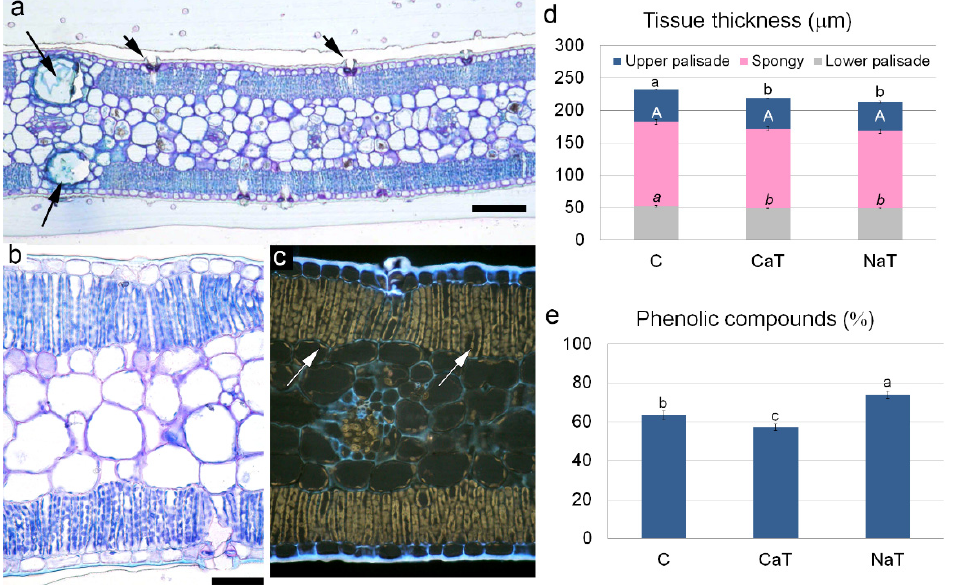
Figure 1. Light ( a , b ) and epi-fluorescence ( c ) microscopy views of leaf lamina cross sections of C . citrinus control leaves. In ( a ), long and short arrows point to glands and cuticular waxes on stomata guard cells, respectively. Effect of salinity on the thickness of upper palisade, spongy and lower palisade parenchyma ( d ), and on the percentage of phenolics ( e ). Mean values and standard errors are shown. In graphs ( d , e ) , different letters correspond to significantly different values between treatments ( p < 0.05). Images in ( b , c ) are at the same magnification; scale bar = 100 μ m in ( a ) and 50 mm in ( b ).